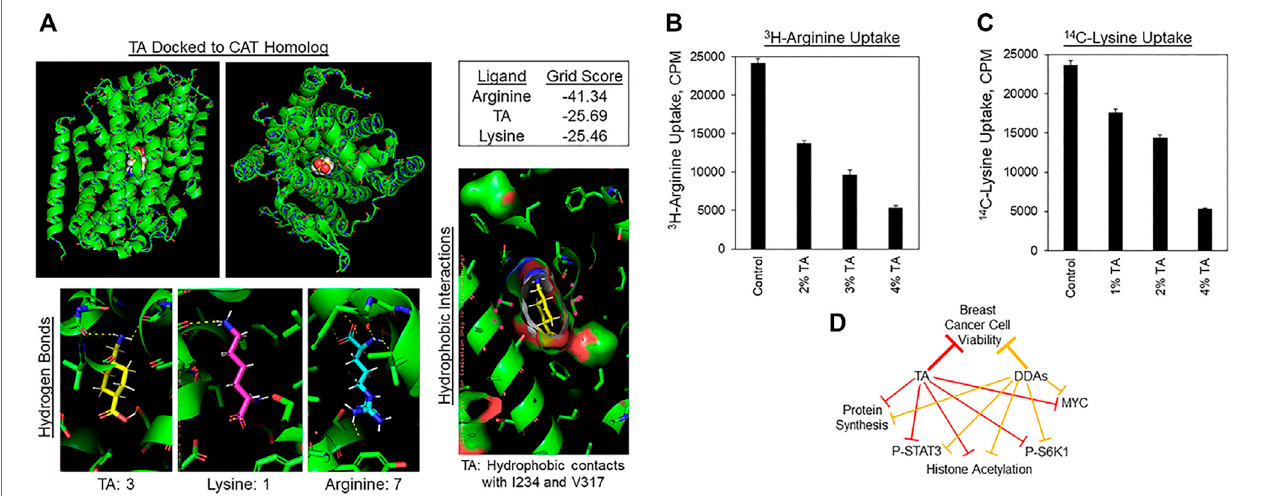
FIGURE 6 | TA inhibits Lys and Arg absorption by cancer cells. (A) Molecular docking of TA into the Arg binding pocket of the bacterial homolog of the Cationic AminoacidTransporters(CATh).Upper-left:ImageofTAdockedtoCAThintheplaneoftheplasmamembrane.Upper-middle:ViewofTAdockedintoCAThorthogonal tothemembrane.Upper-right:BindingenergyscoresforArg,TA,orLysbindingtotheArgbindingpocketofCAThestimatedbyDOCK6.7.Lower-left:Hydrogenbonds between CATh and TA, Lys, or Arg predicted by PyMol. Lower-right: Hydrophobic contacts between I234 and V317 of CATh with the cyclohexane ring of TA predictedbyPyMol. (B) 3 H-ArguptakebyMDA-MB-468cellsduringa2 hlabelingpulseinthepresenceoftheindicatedconcentrationsofTA.Resultsaretheaverageof sixreplicatesandpresentedastheaverage ± S.D.These fi ndingsarerepresentativeofthreebiologicalreplicateswithsimilarresults. (C) 14 C-LysuptakebyMDA-MB-468 cellsduringa2 hlabelingpulseinthepresenceoftheindicatedconcentrationsofTA.Resultsaretheaverageofsixreplicatesandpresentedastheaverage ± S.D.These fi ndings are representative of three biological replicates with similar results. (D) Model displaying the overlapping biochemical mechanisms by which TA and DDAs may suppress breast tumor